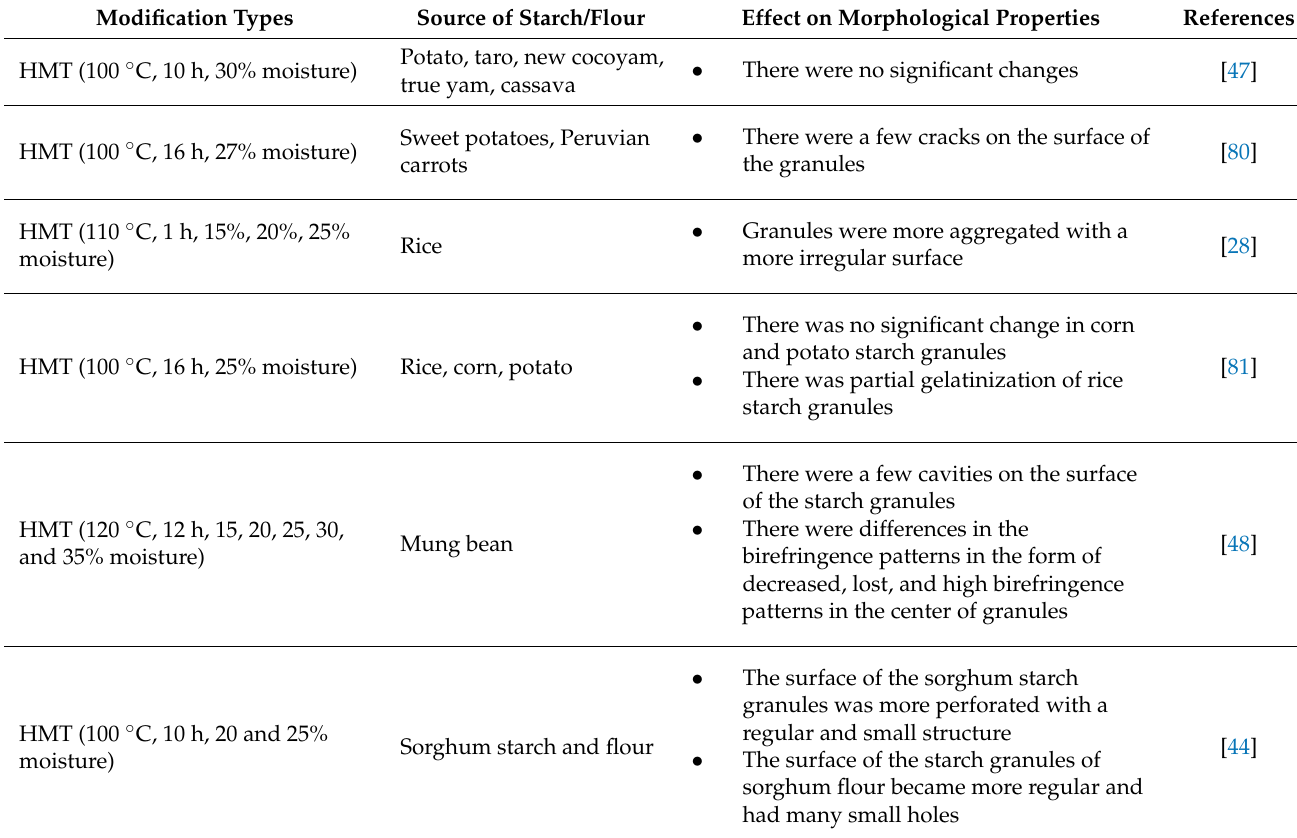
Table 2. Several studies related to the effect of hydrothermal modifications on the morphology of starch and